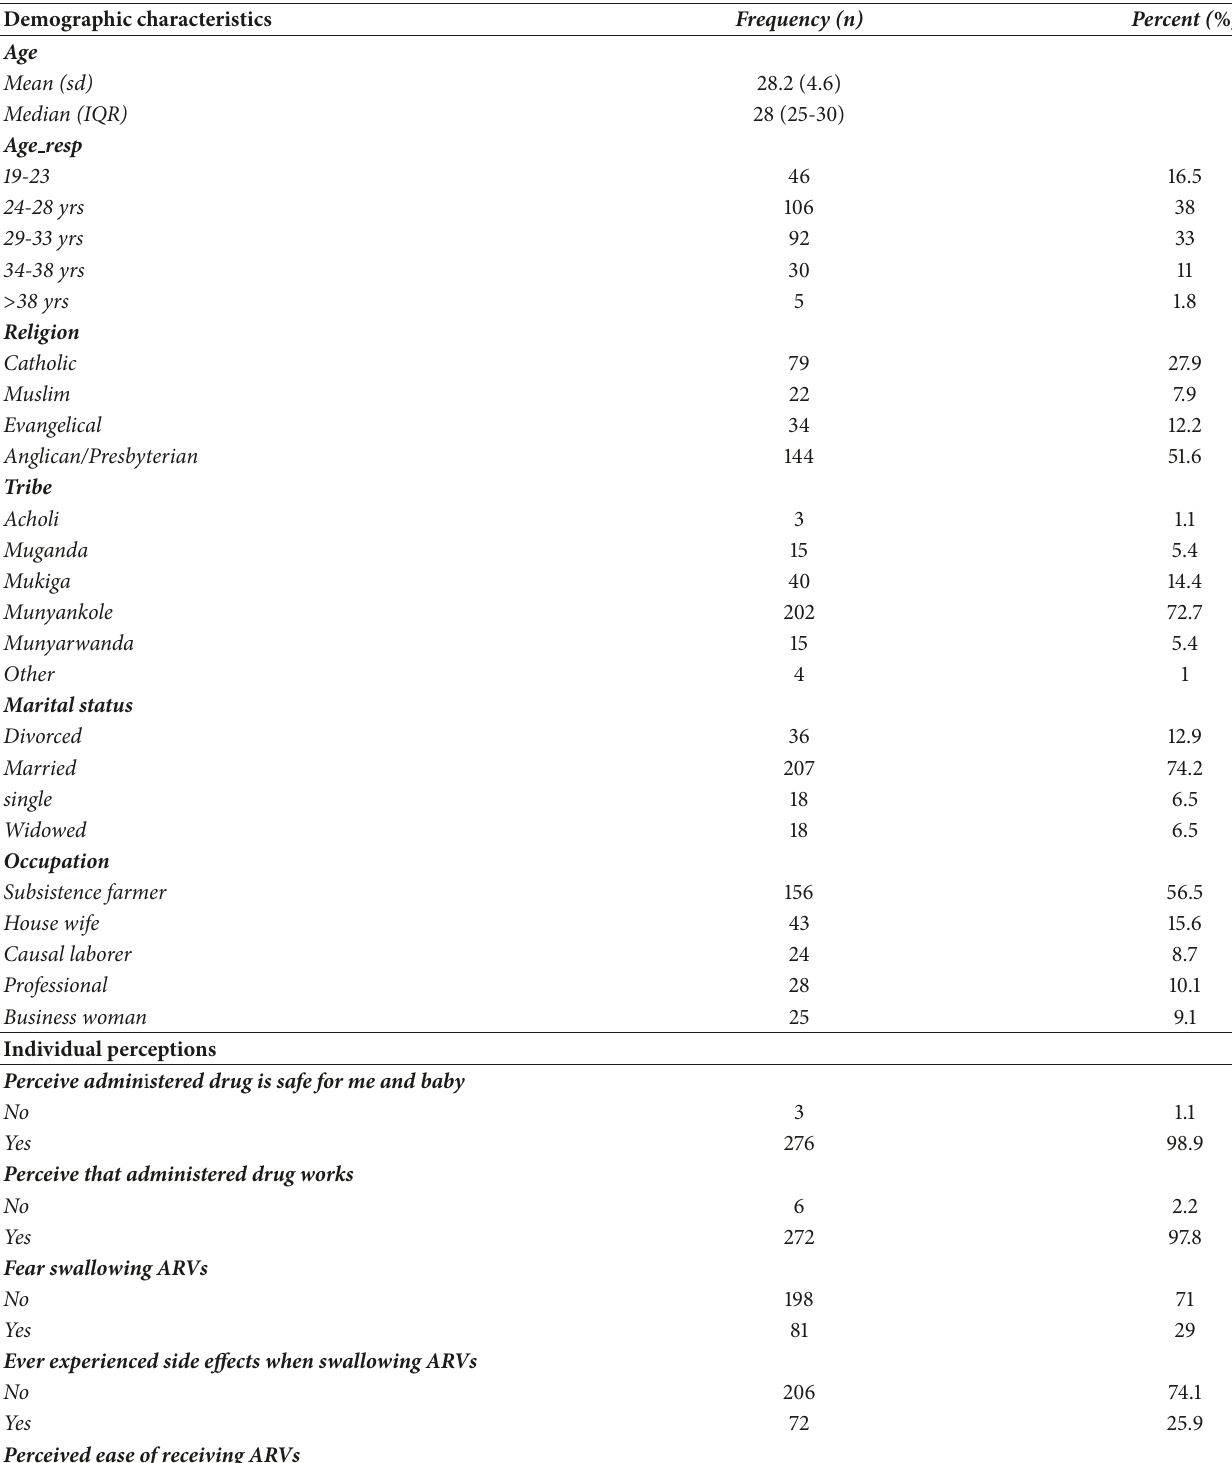
Table 1: Social demographic characteristics of the mothers (N=279) and individual perceptions of HIV positive women towards highly active antiretroviral therapy